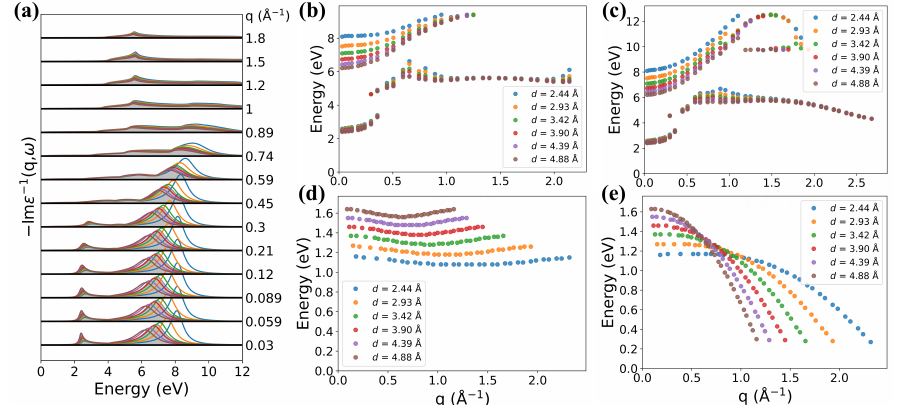
Figure 5. ( a ) Calculated loss functions along the Γ M direction with LFE at different interlayer distance (light blue line for d = 2.44 Å, orange line for d = 2.93 Å, green line for d = 3.42 Å, brown line for d = 3.90 Å, violet line for d = 4.39 Å and brown line for d = 4.88 Å). The shaded background gives the loss functions of d = 3.70 Å case for comparison. ( b , c ) show the loss function peaks along the Γ M direction with and without LFE, respectively. ( d , e ) show the loss function peaks along the Γ A direction with and without LFE, respectively. The Fermi level is fixed at E F = 1.555